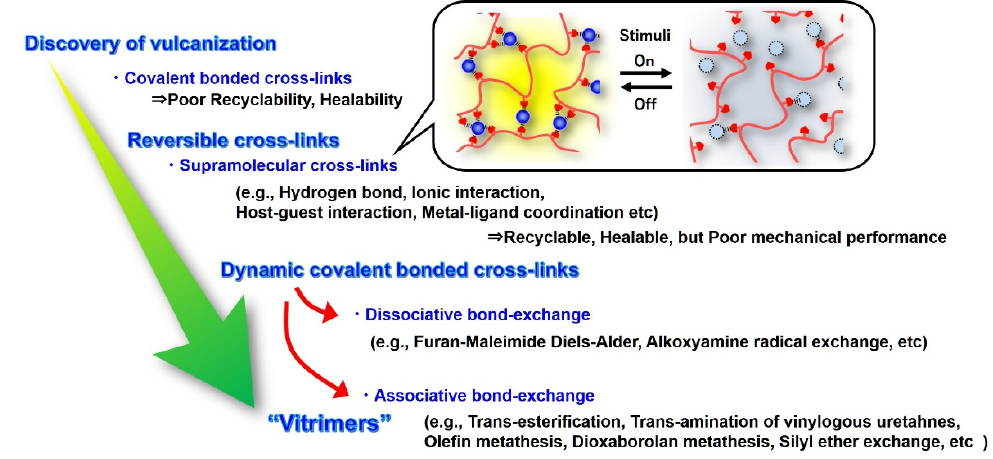
Figure 1. Evolution of cross-linked materials from the discovery of vulcanization to vitrimers.